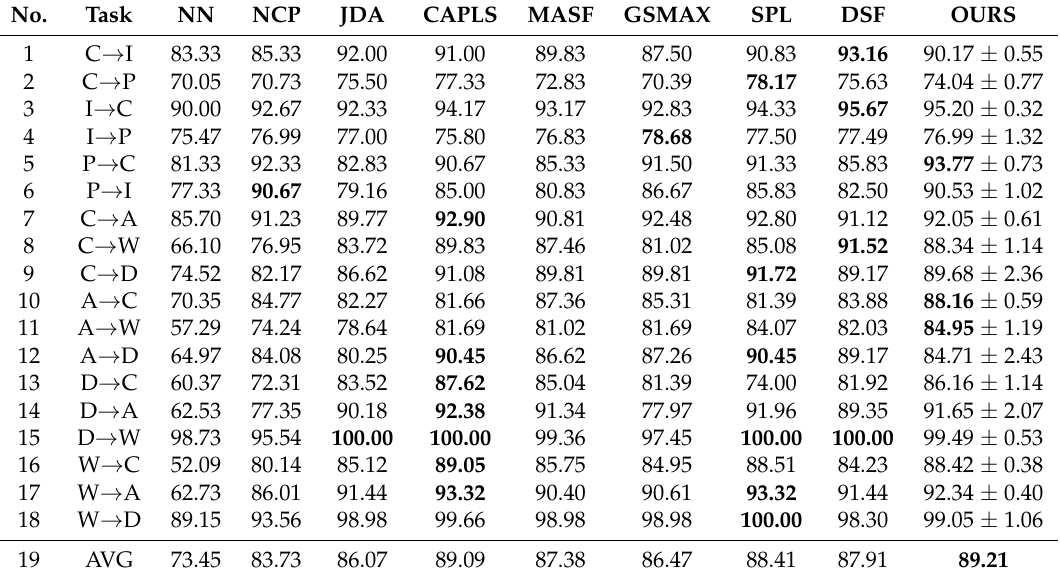
Table 3. Performance (accuracy %) on ImageCLEF (Cross Language Evaluation Forum (CLEF)) (Nos. 1–6) and Office-Caltech10 (Nos. 7–18). CAPLS, confidence-aware pseudo label